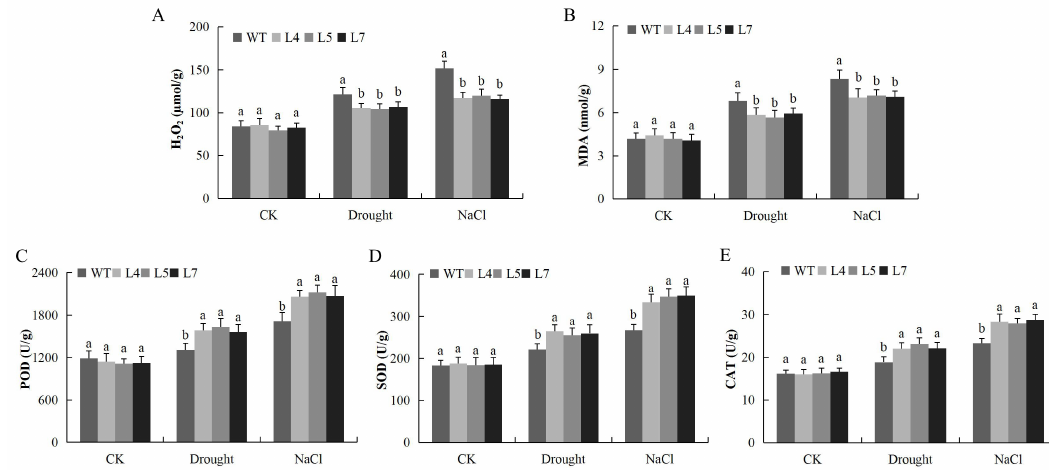
Figure 10. Determination of oxidant and antioxidant enzymes under drought and salt stress conditions ( A ) Quantitative determination of hydrogen peroxide (H 2 O 2 ) concentration ( B ) Quantitative determination of malondialdehyde (MDA) concentration ( C ) Quantitative determination of POD concentration. ( D ) Quantitative determination of SOD concentration. ( E ) Quantitative determination of CAT in leaves of wild type and transgenic Arabidopsis lines (L4, L5 and L7) after 8-day post stress exposure. Each experiment was repeated three times. Bar indicates standard error (SE). Different letters indicate significant differences between wild type and the transgenic Arabidopsis lines (ANOVA; p < 0.05). CK: normal